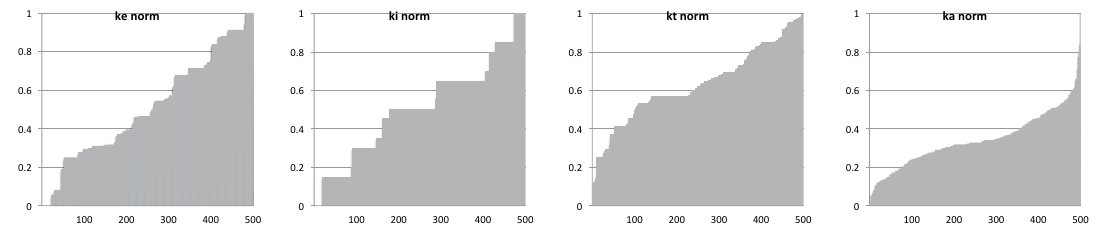
Figure 7. Distribution of the normalised scores of the fundamental characteristics of S .